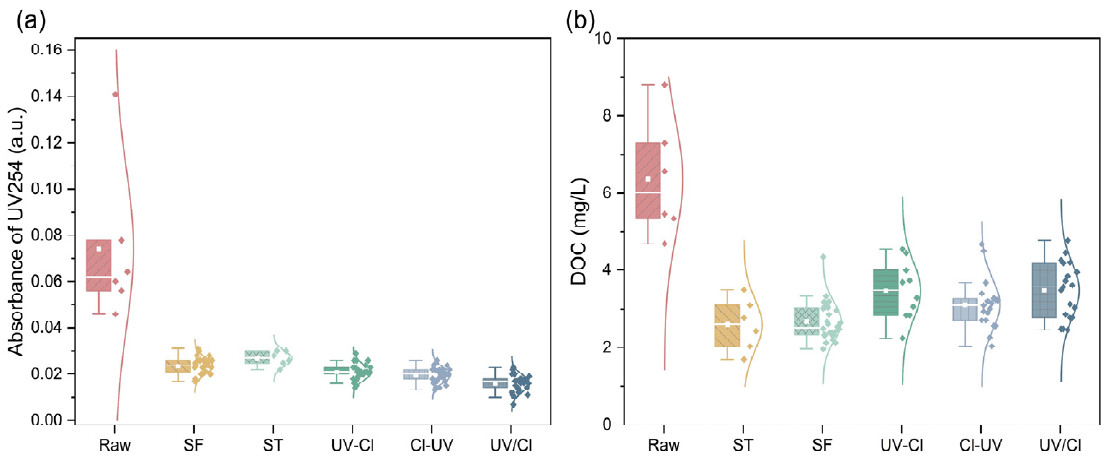
Figure 1. Changes of UV 254 ( a ) and DOC ( b ) in raw water (Raw), treated effluents from settling tank (ST), sand filtration (SF), UV-Cl, Cl-UV and UV/Cl. The change of fluorescence EEM was in accordance with the change of UV 254 , where the intensity of total fluorescence was continuously decreased in Raw, ST, SF and com- bined processes (Figure 2a). Amongst combined processes, UV/Cl was the most effec- tive one to reduce fluorophores. PARAFAC analysis of fluorescence EEM derived five components—C1 to C5 refers to terrestrial humic-like, protein-like, humic-like, fulvic acid- like and tryptophan-like compounds, respectively (Figure S5, Table S2) [27,43–48]. As shown in Figure 2b,c, C3, C4 and C5 in raw water samples were reduced by coagula- tion/flocculation, while C1 was increased. After that, the relative contents of C1-C5 were maintained at similar levels in each unit except UV/Cl, where C1 and C3 were reduced with increased C4 and C5. The effective reduction of humic acid-like compounds (C1 and C3) in UV/Cl could be attributed to the generated radicals [49]. The increased fulvic acid-like compounds (C4) might be transformed from the reduction of the relatively large humic acid-like compounds. The tryptophan-like compounds (C5) in this study were similar to the reported one, which was strongly correlated with the biodegradability [50]. Hence, the increased C5 after UV/Cl implies the improved biodegradability. C2 are identified as synthetic organics compounds or anthropogenic compounds [51], which are relatively recalcitrant and changed slightly in the current study. Molecular weight shifts of organics are shown in Figure 3. The relatively large molecules (biopolymer, humic substances and building blocks) were effectively removed and transformed into LMW molecules in the pre-treatment processes (Figure 3a). Com- pared to those of SF, HOC and LMW neutrals were increased after combined processes, and LMW neutrals were most abundant after UV-Cl, followed by UV/Cl (Figure 3b,c). The increased HOC could be attributed to the hydrophobic halogenated products formed from the reaction between NOM and chlorine [52]. Higher LMW compounds after com- bined processes imply that there were more abundant small organic molecules. Those small molecules were transformed from the larger molecules due to the breakdown by the combined processes